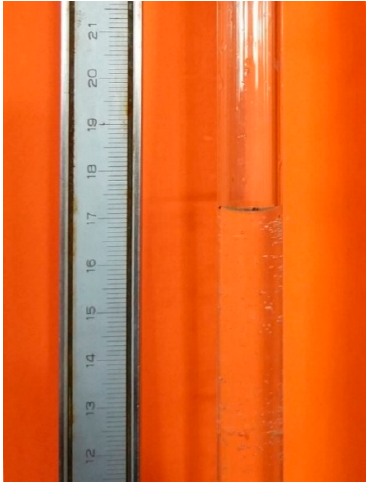
Figure 4. The original drawing of the liquid level.